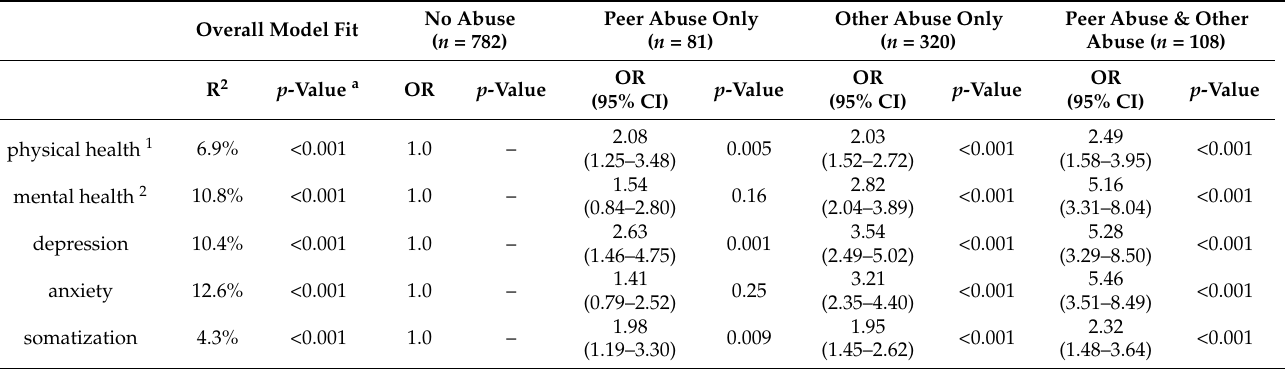
Table 3. Sex-specific adjusted logistic regression analyses for female patients ( n = 1,291), showing the influence of ACEs and peer abuse on physical and mental health